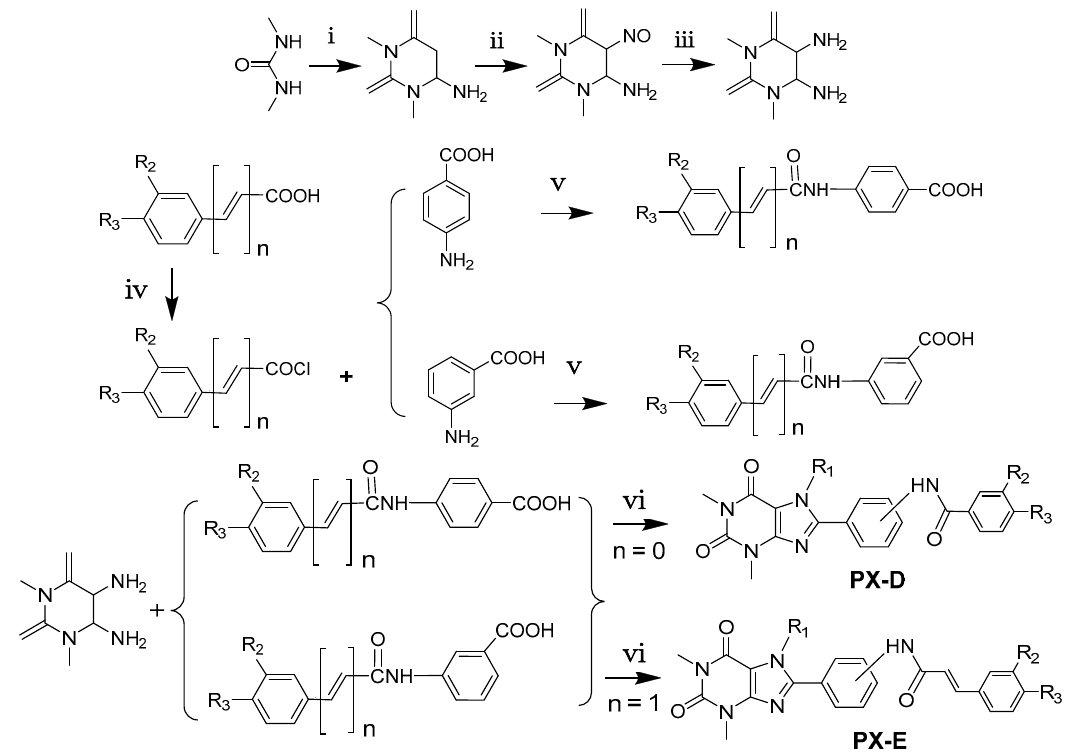
Scheme 1. General method for the synthesis of phenylxanthine derivatives of series PX-D and PX-E, n = 0 or